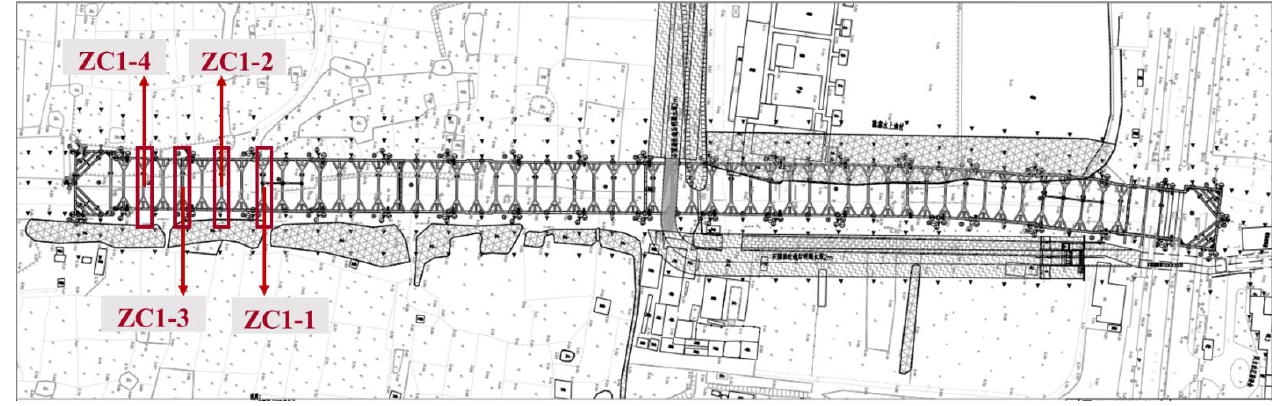
Figure 3. Waterlands Resort East Station Project of Shenzhen Metro Line 12.